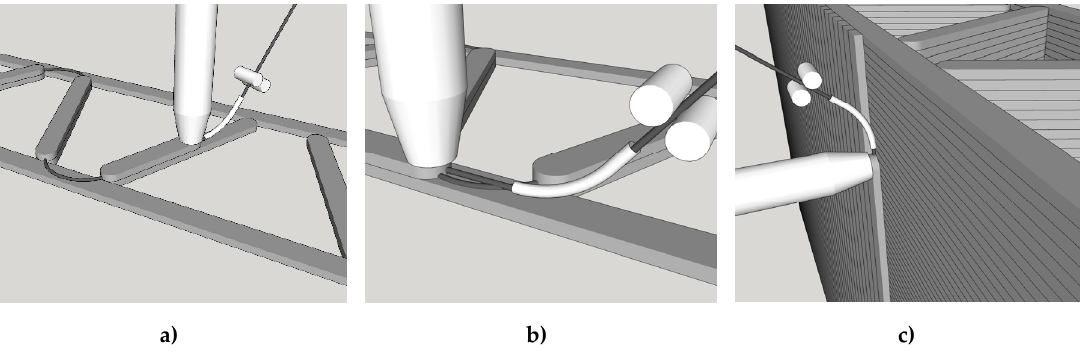
Figure 7. Implementation aspects for integration of MCF reinforcement between concrete layers: ( a ) continuous deposition of MCF while concrete is deposited selectively, ( b ) creating an overlap of MCF yarns, ( c ) vertical deposition of MCF and